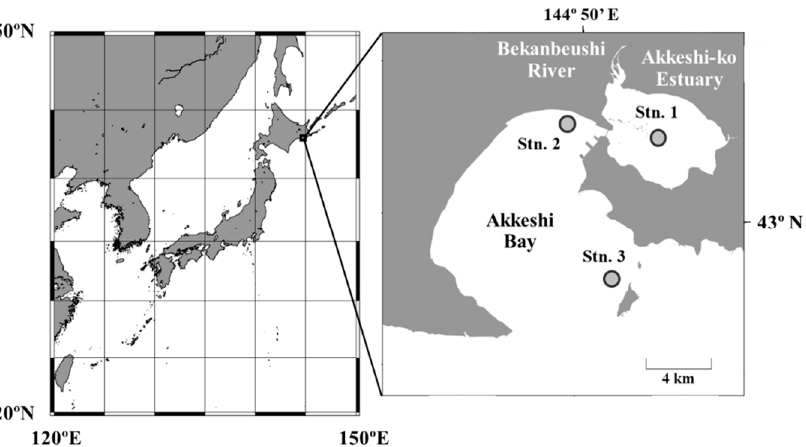
Figure 1. The locations of the three sampling stations in Akkeshi-ko Estuary and Akkeshi Bay, Hokkaido, Japan.